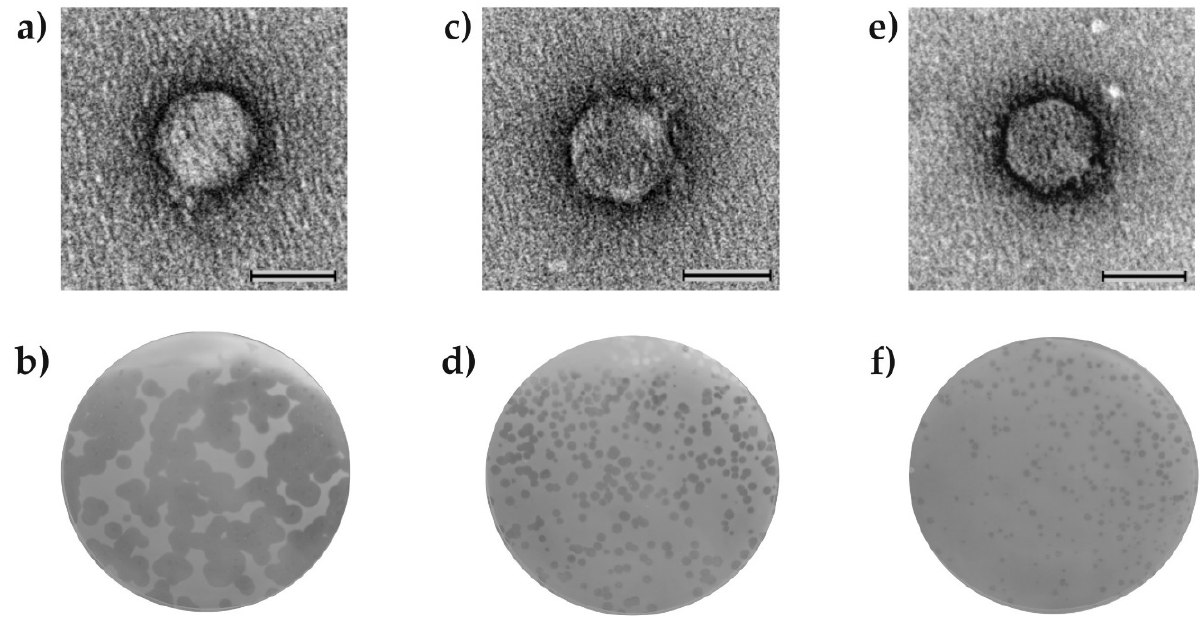
Figure 1. Visualization of the virion and plaques of the ( a , b ) Bolek, ( c , d ) Lolek, and ( e , f ) Tola phages. The scale bar represents 50 nm ( a , c , d ). The scale bar represents 50 nm ( a , c , d